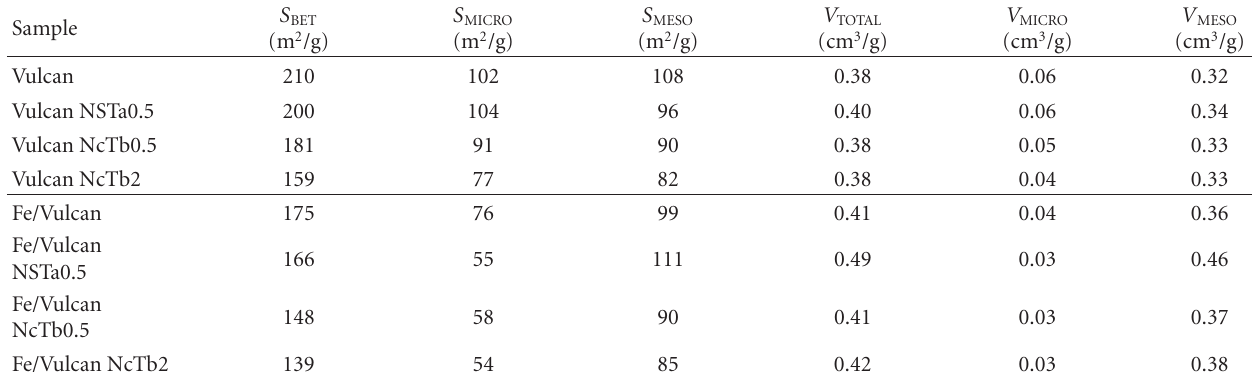
Table 3: Textural properties of the supports and Fe